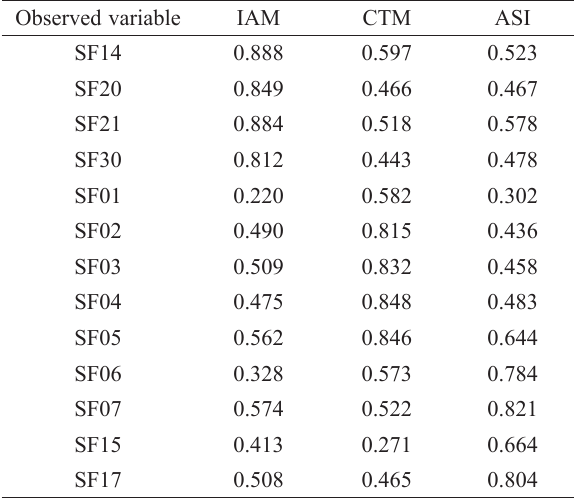
Table 7. Cross loadings for individual observed variables Observed variable